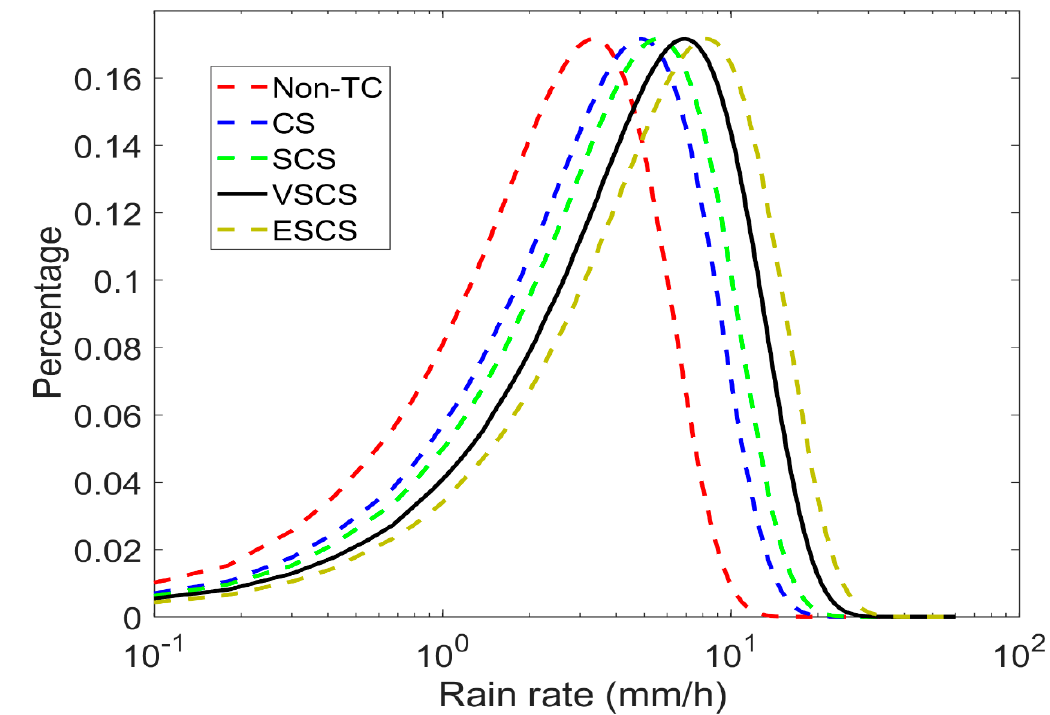
Figure 12. The probability density function of different rainfall intensities for various rainfall types (Non-TC, CS, SCS, VSCS, and ESCS) over land.